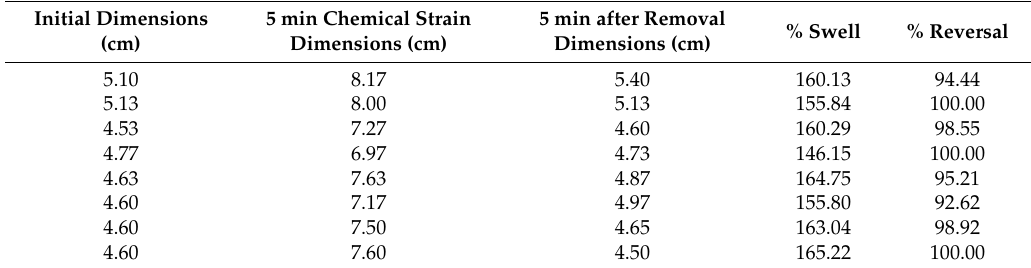
Table 5. Results of Chemical Pre-strain [23,24].